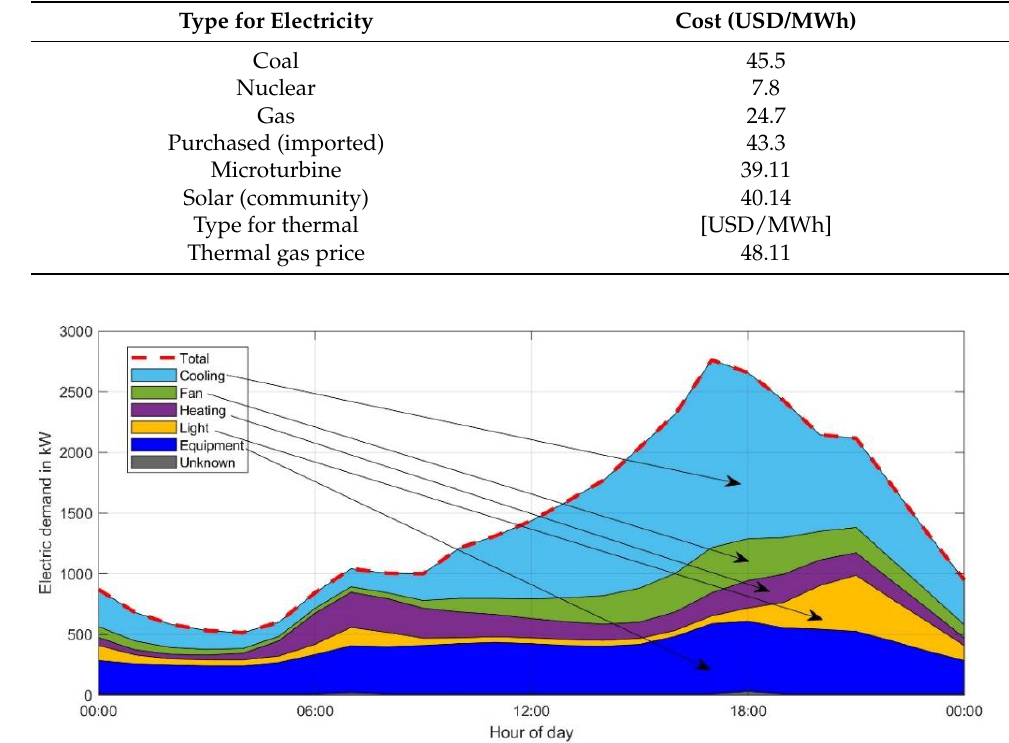
Table 1. Generation costs for Atlanta area as input [25–27].